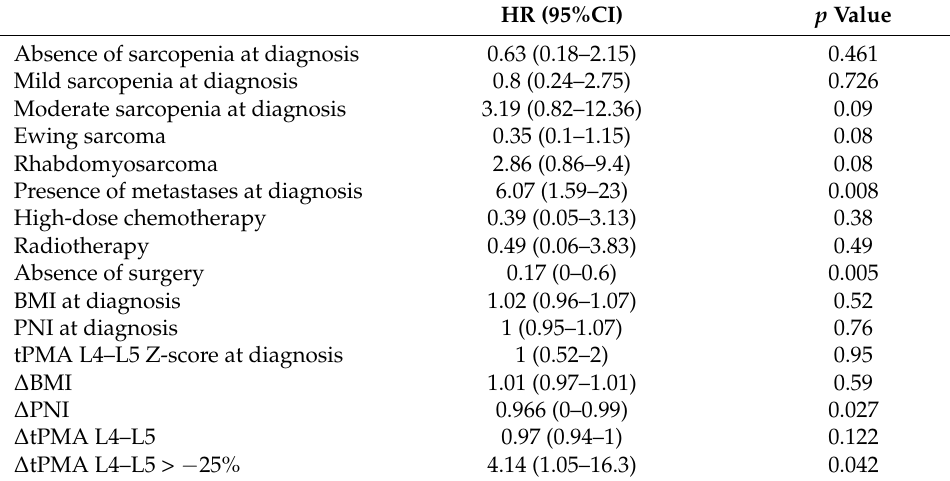
Table 3. Univariate analysis of clinical characteristics, nutritional status, and sarcopenia for overall